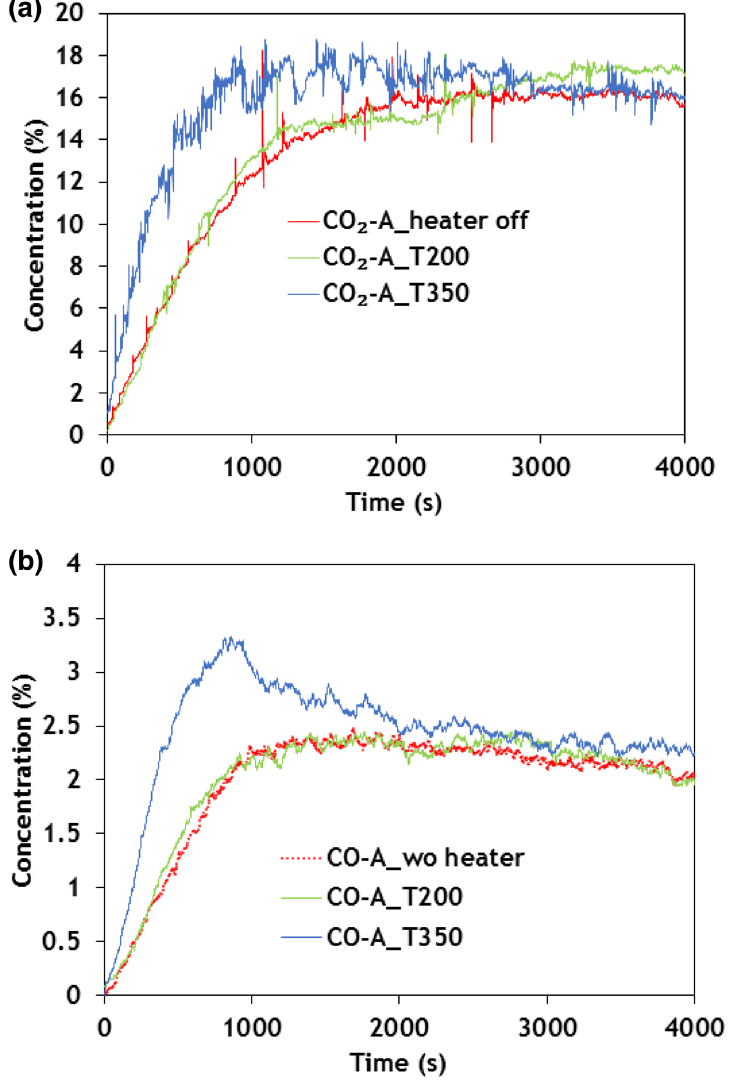
Fig. 15 Gas products of coal A at various temperatures a CO 2 and b